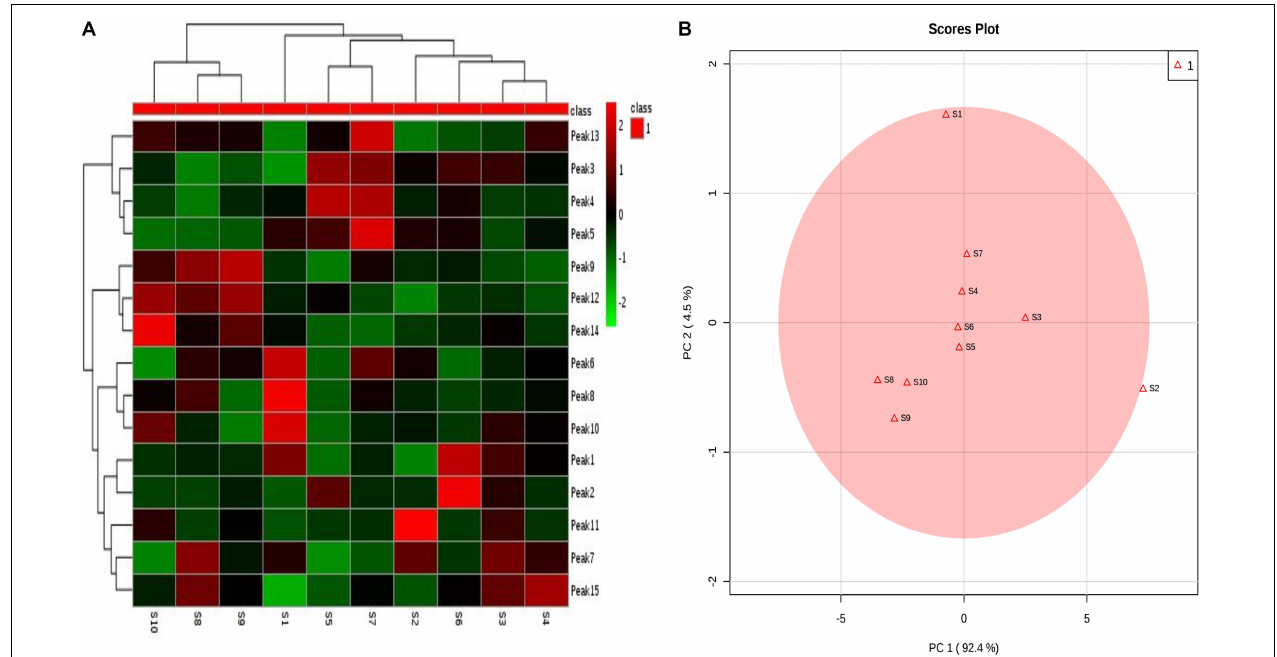
FIGURE 4 | Syringa oblata samples from different sources: (A) heatmaps of 15 constituent content; (B) principal component analysis (PCA)